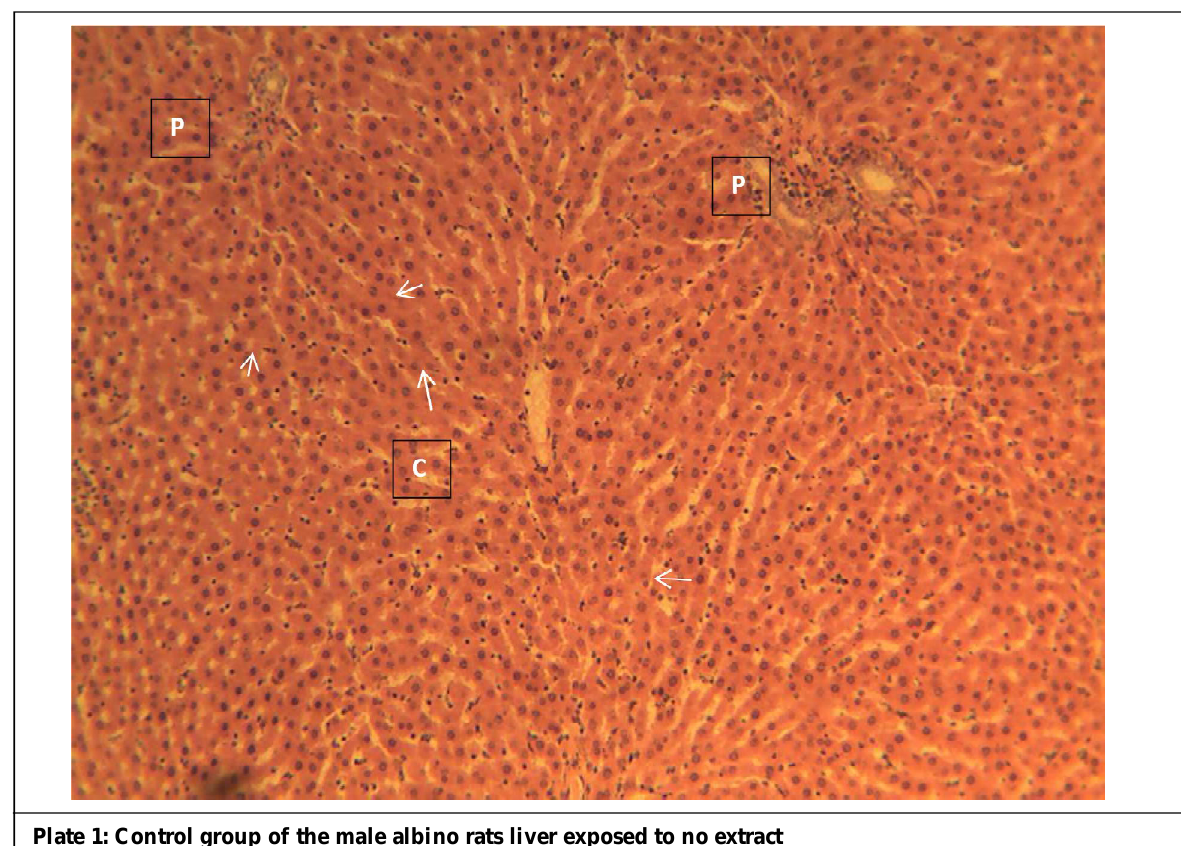
Plate 1: Control group of the male albino rats liver exposed to no extract